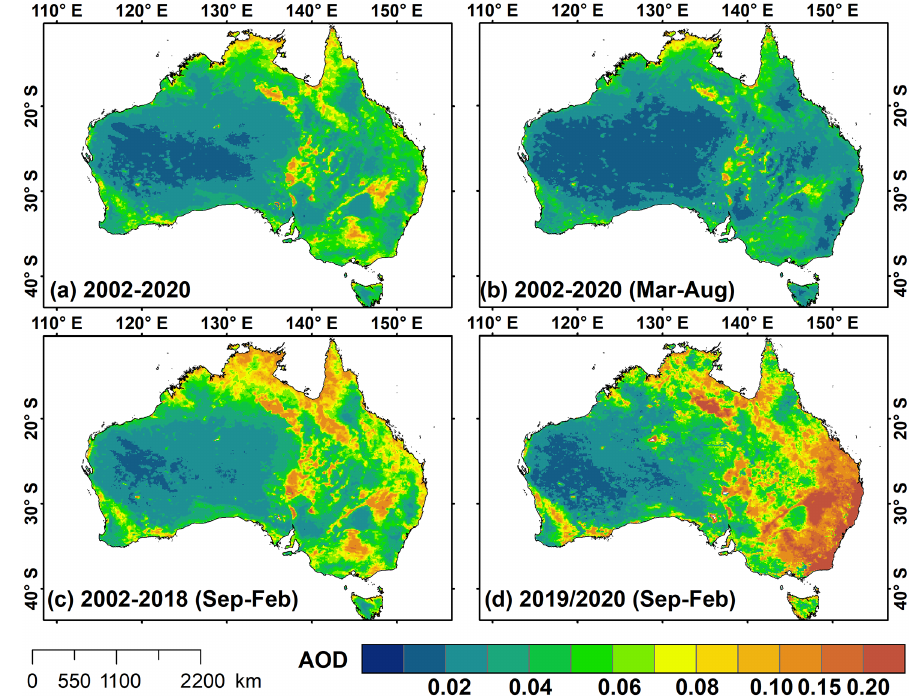
Figure 4. Spatial distributions of Aqua MODIS DB AOD at 550nm over Australia during the following periods between 2002 and 2020 in Australia: (a) July 2002–May 2020, (b) March–August (non-BB period) of 2002–2020, (c) September–February (BB period) of 2002–2018, and (d) the BB period of